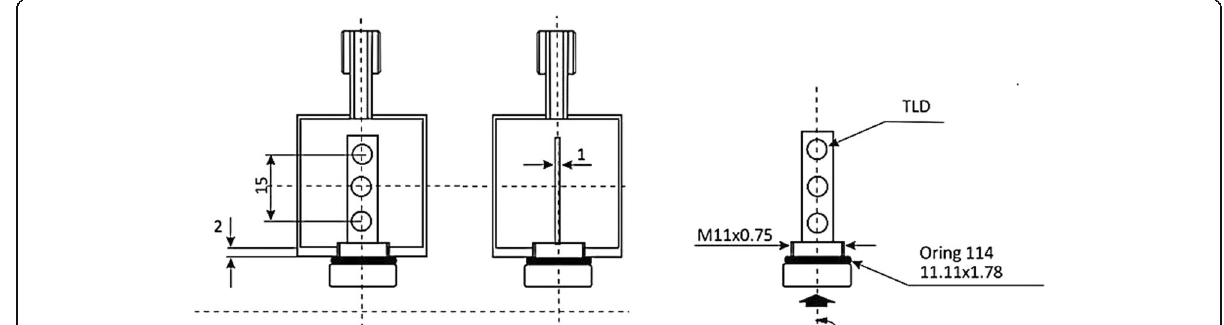
Fig. 7 Technical drawing of the cylindrical phantom containing TLD chips surrounded by 90 YCl 3 aqueous solution. Custom PMMA cylindrical inserts were manufactured at ENEA-INMRI to perform absorbed dose measurements with LiF:Mg,Cu,P thermoluminescence detectors